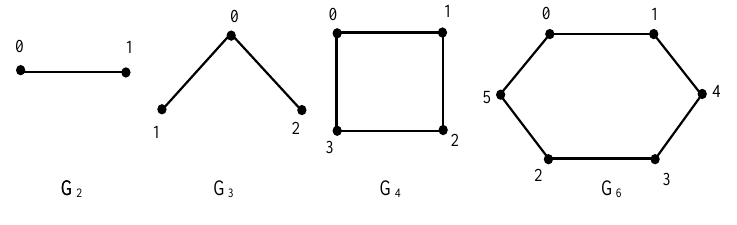
Figure 6. Showing G 2 , G 3 , G 4 and G 6 .